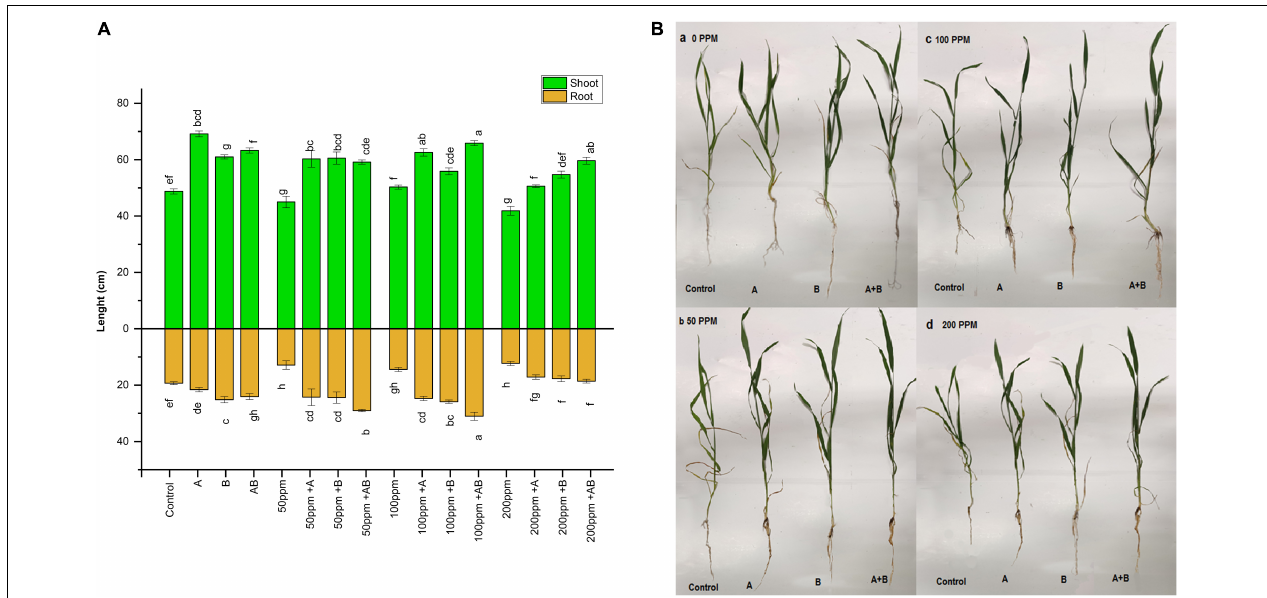
FIGURE 2 | (A) Effect of heavy metal–resistant plant growth–promoting bacteria on the length of shoots and roots of wheat ( Triticum aestivum ) under control and heavy metal (Cd, Ni, Pb) stress conditions. Values are mean of three replicates. Bars represent the standard error of means. Different letters above the bars indicate statistically significant difference between treatments at P ≤ 0.05. Details of treatments are the same as those in Figure 1 . (B) Effect of heavy metal (a) 0 ppm, (b) 50 ppm, (c) 100 ppm, and (d) 200 ppm resistant plant growth–promoting bacteria on the growth of wheat ( Triticum aestivum ) under control and heavy metal (Cd, Ni, Pb) stress conditions. Details of treatments are the same as those in Figure 1